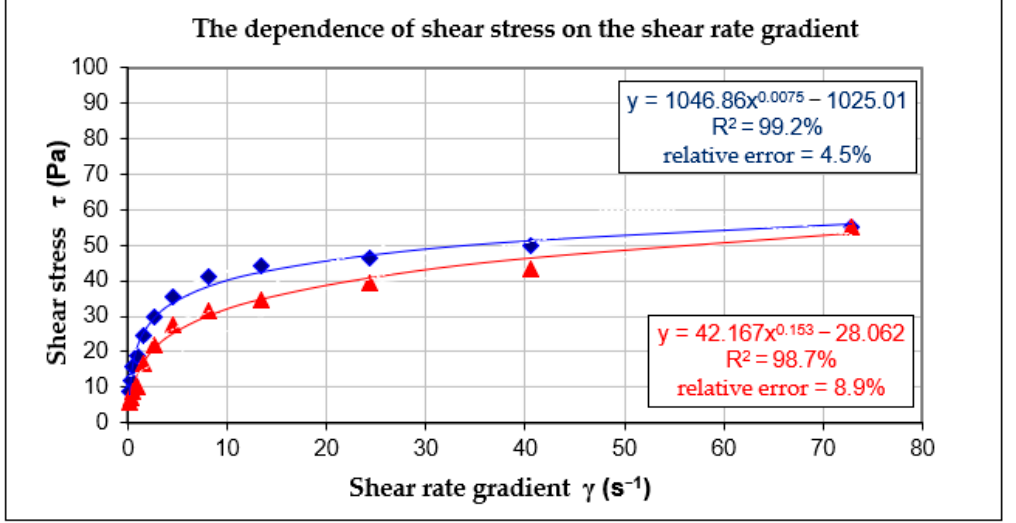
Figure 3. The dependence of shear stress on the shear rate of the cement paste created on the basis of CEM II with the water–cement ratio (w/c) = 0.50.